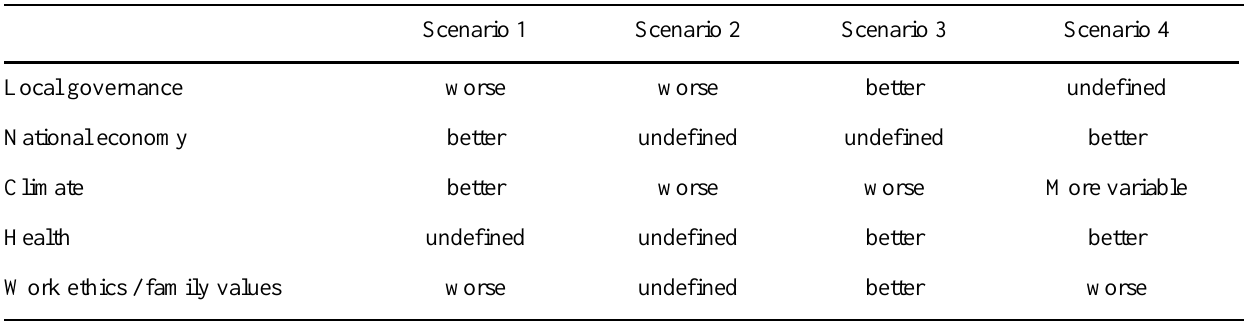
Table 3. Starting points for the scenarios. The conditions for the starting point of the storyline are defined as being better, undefined, or worse than the present